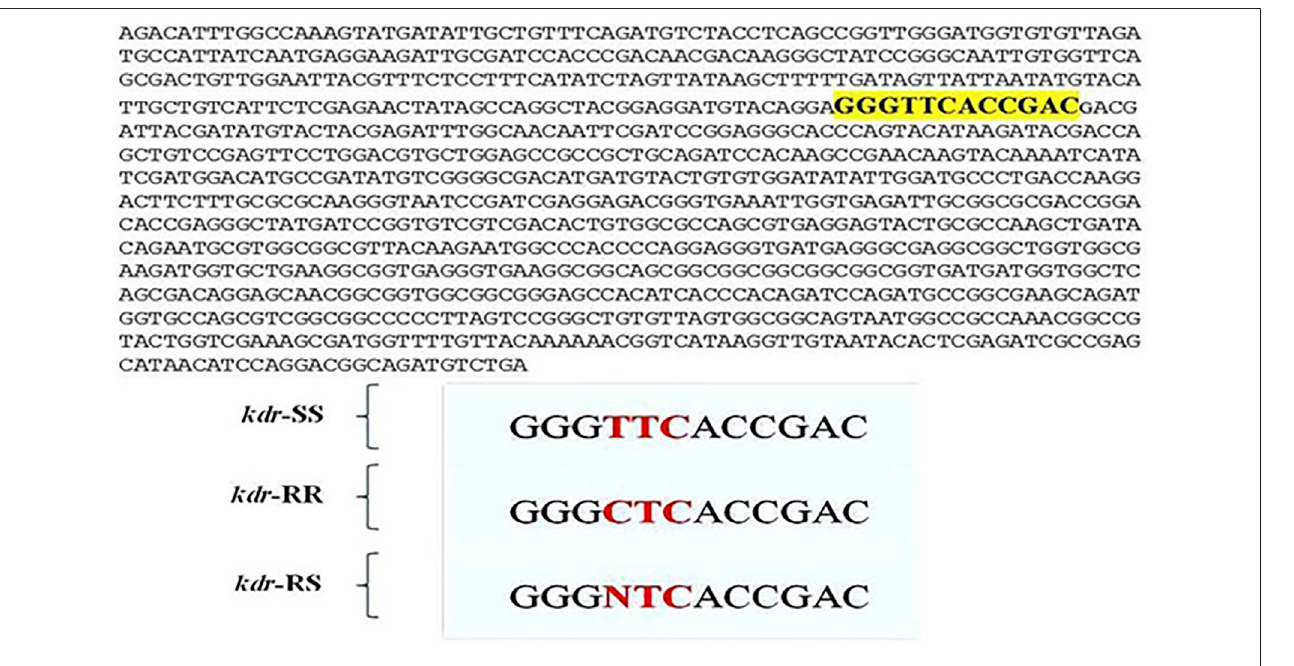
Frontiers in Environmental Science |